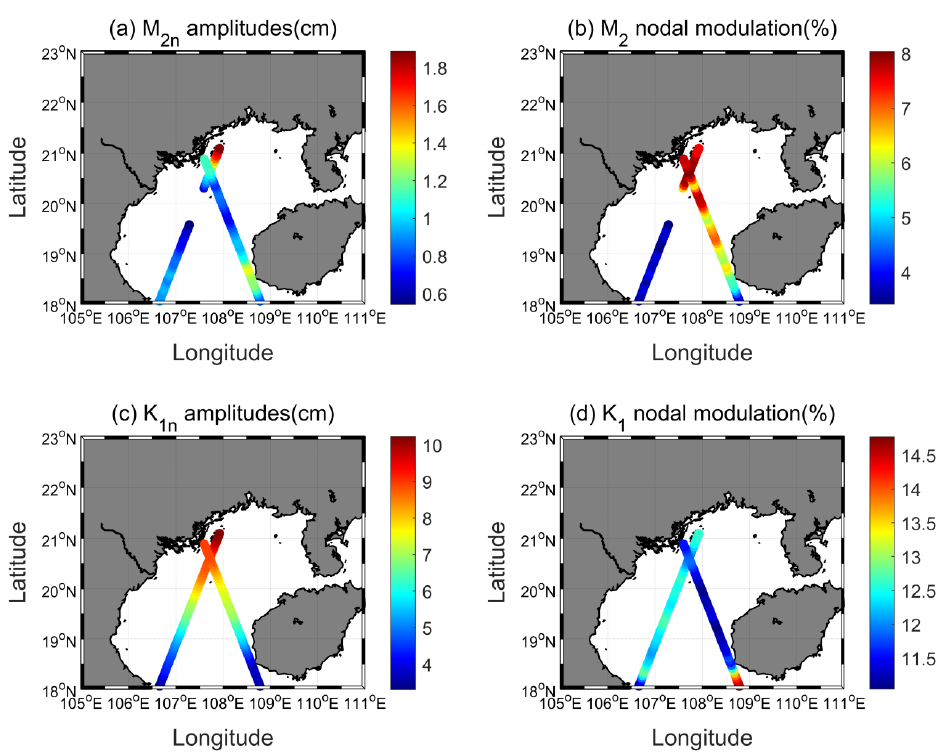
Figure 6. Estimated nodal amplitudes and nodal modulations from T/P-Jason observations in the Gulf of Tonkin: ( a ) M 2n amplitudes, ( b ) M 2 nodal modulations, ( c ) K 1n amplitudes, and ( d ) K 1 nodal modulations.